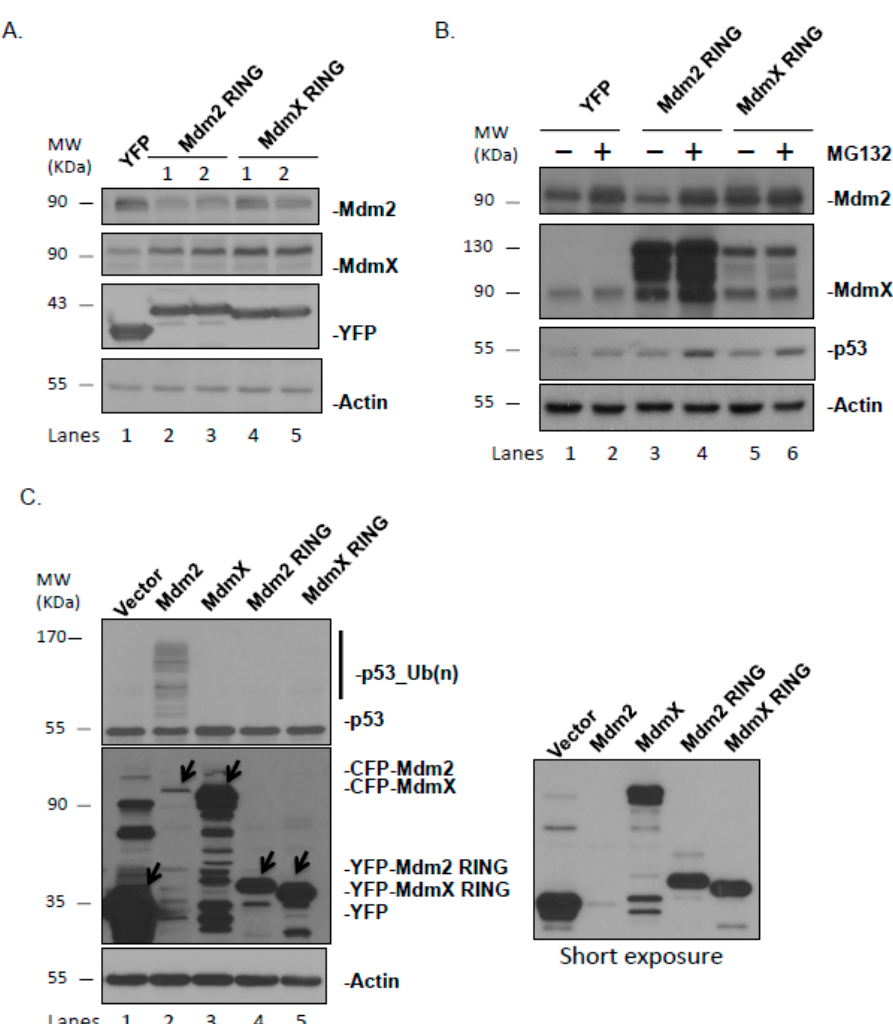
Figure 2. Effects of the ectopically expressed Mdm RING domains on p53 ubiquitination and endogenous levels of Mdm2 and MdmX. ( A ) U2OS cells were transfected with YFP-Mdm2 RING, and YFP-MdmX RING. The total cell lysate was immunoblotted for the protein levels of full-length Mdm2 and MdmX. ( B ) U2OS cells were transfected with YFP-Mdm2 RING and YFP-MdmX RING. The total cell lysate was immunoblotted for the protein levels of full-length Mdm2, MdmX and p53, and compared in the absence and presence of the proteasome inhibitor MG132 treatment. ( C ) U2OS cells were transfected with CFP-Mdm2, CFP-MdmX, YFP-Mdm2 RING, and YFP-MdmX RING. The total cell lysate was immunoblotted for the p53 ubiquitination. The arrows indicate ectopically expressed proteins. 2.4. E ff ect of the Ectopic Mdm2 and MdmX RING Domains on the Cellular Level of p53 under Normal